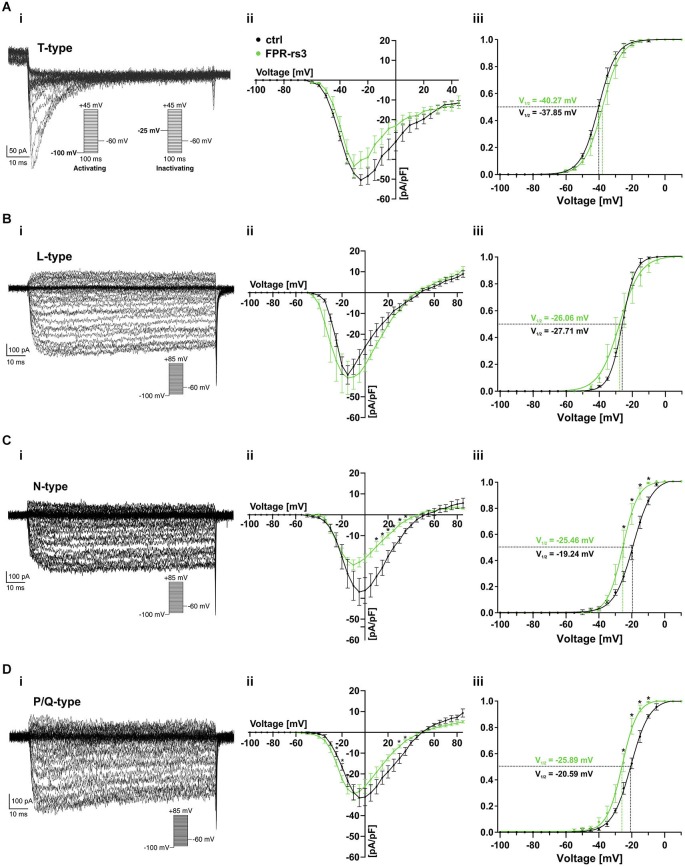
Voltage-gated Ca2+ currents. (A–D) Representative Ca2+ current traces isolated either biophysically (prepulse inactivation protocol; (Ai)) or pharmacologically (nifedipine (10 μM; Bi); ω-conotoxin-GVIA (2 μM; Ci); ω-agatoxin IVA (200 nM; Di)). Step protocols as indicated. Absolute (Aii–Dii) and normalized (Aiii–Diii) peak current densities are plotted as a function of membrane depolarization. Activation curves (Aiii–Diii) are fitted according to a sigmoidal Boltzmann-type equation. Membrane voltage inducing half-maximal activation (V½) as indicated. Data are mean ± SEM; *p < 0.01, two-tailed Student’s t-test.